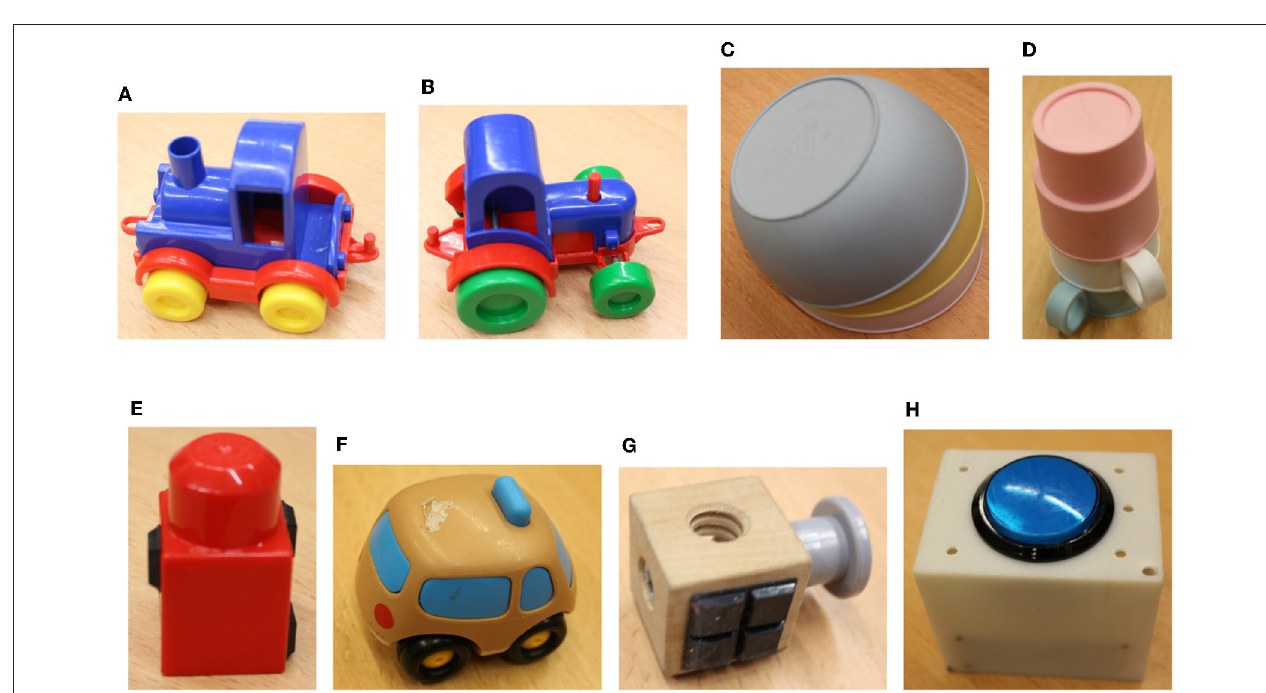
FIGURE 8 | Eight different types of objects used in the experiments. The affordance expected to be linked to these objects is indicated in bold. (A) Toy locomotive: pushable, liftable . (B) Toy locomotive: pushable, liftable . (C) Pile of bowls: pushable . (D) Pile of mugs: pushable . (E) Duplo bricks: pushable, liftable . (F) Toy car: pushable . (G) Wooden cube: pushable, liftable . (H) Buttons: pressable .